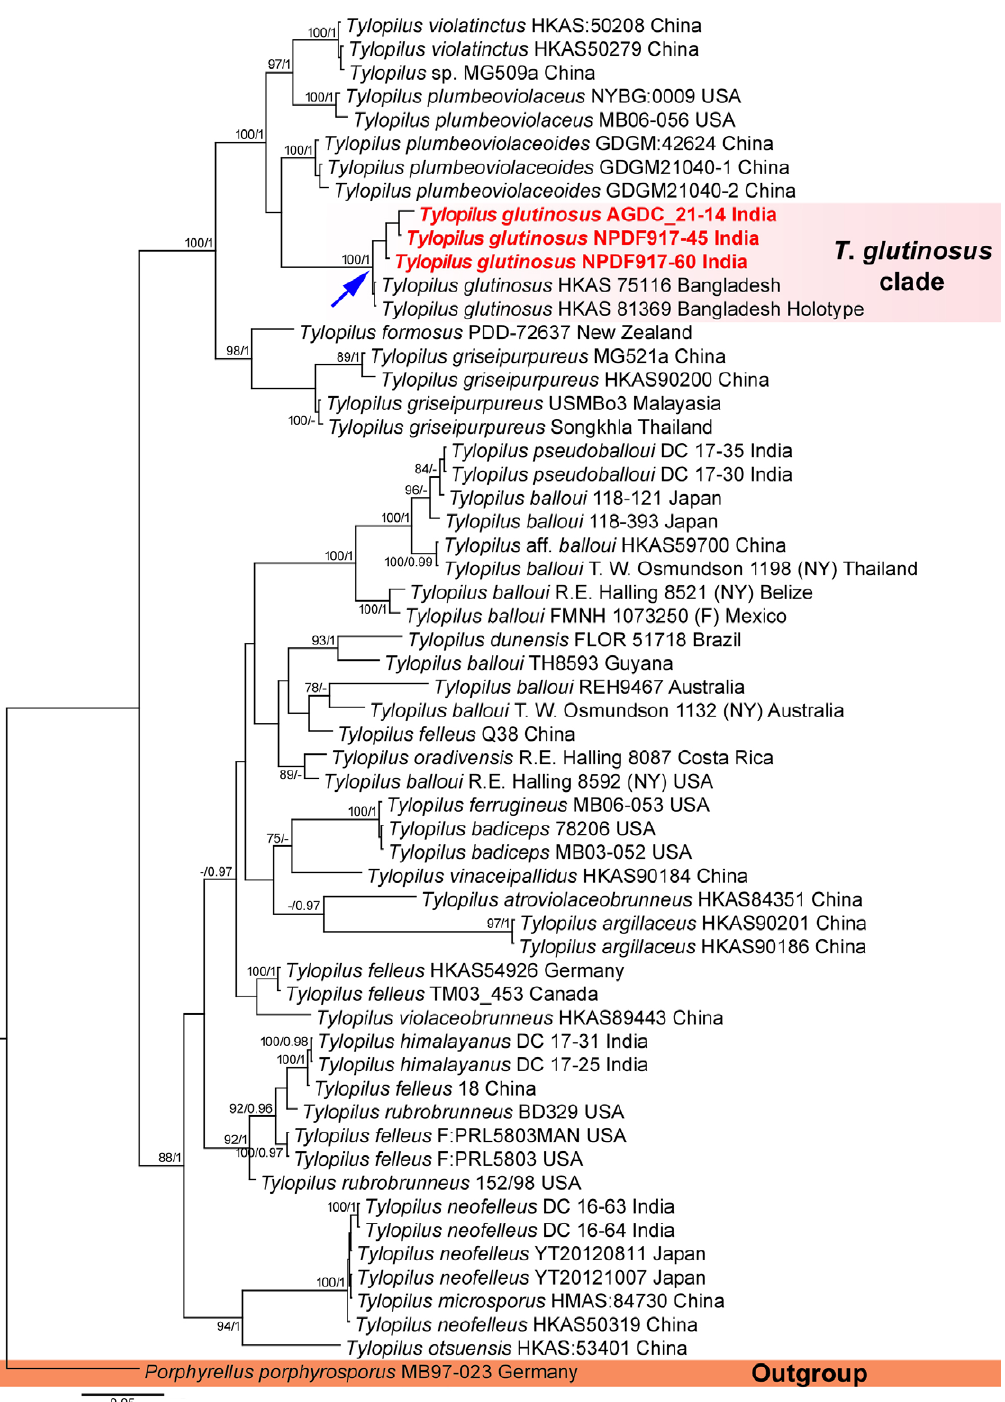
Figure 2. Maximum-likelihood (ML) and Bayesian (BI) phylogram inferred from raxmlGUI 2.0 on a concatenated dataset of nrITS and nrLSU sequence data of Tylopilus s.s. species. Porphyrellus porphyrosporus is used as outgroup taxon. Support values in either the ML Bootstrap percentage or BI posterior probabilities values are indicated. MLB ≥70% are shown on the left of “/” and BPP ≥0.95 are shown on the right above or below the branches at nodes. Three Indian collections of Tylopilus glutinosus are highlighted in red and bold font in the